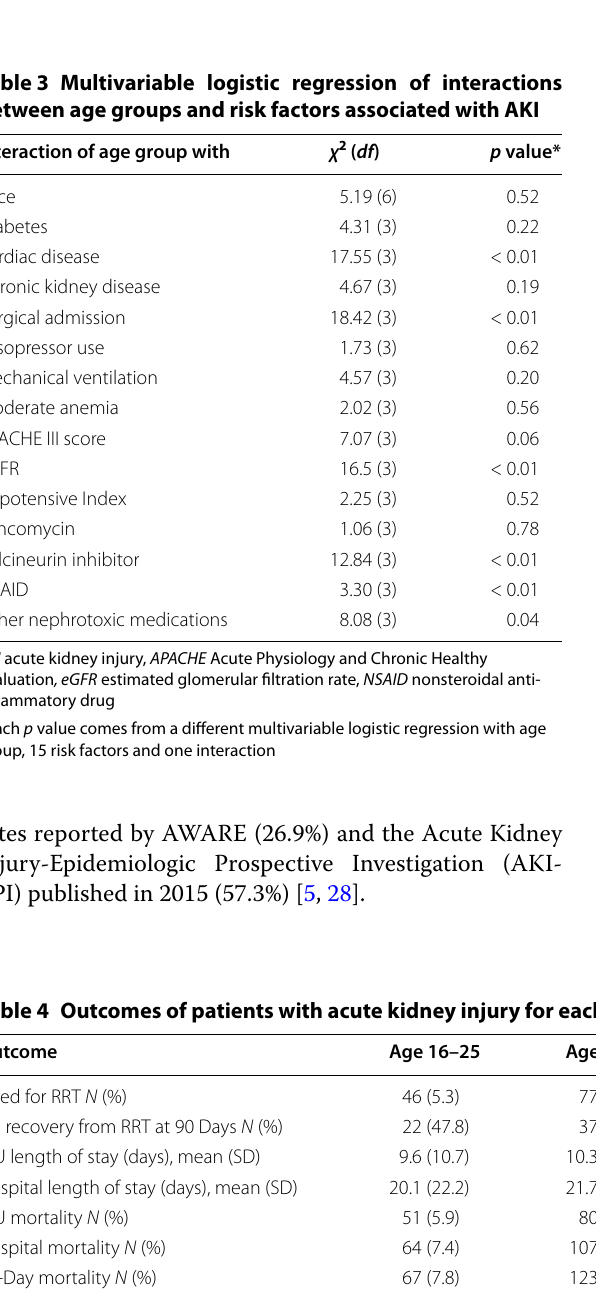
RRT renal replacement therapy, ICU intensive care unit, SD standard deviation Table 5 Multivariable logistic regression of outcomes related to acute kidney injury by age categories (years)